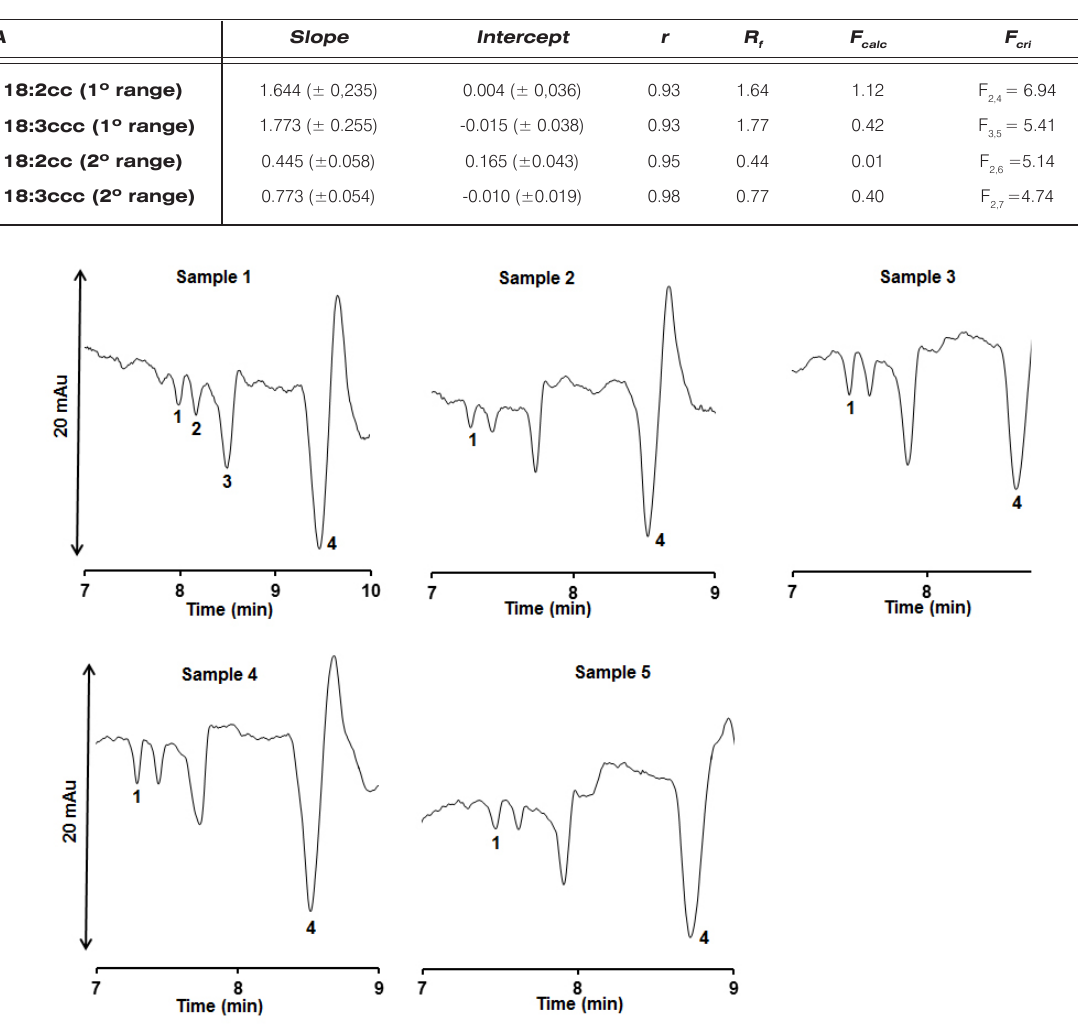
Figure 7. Electropherograms obtained through the best condition by 3 3 Box Behnken experimental design by Hara & Radin extraction method of five genuine replicates of forage. Peaks: 1-C16:0, 2-C18:2, 3-C18:3 and 4-C13:0. Operational conditions: injection 4 s 12.5